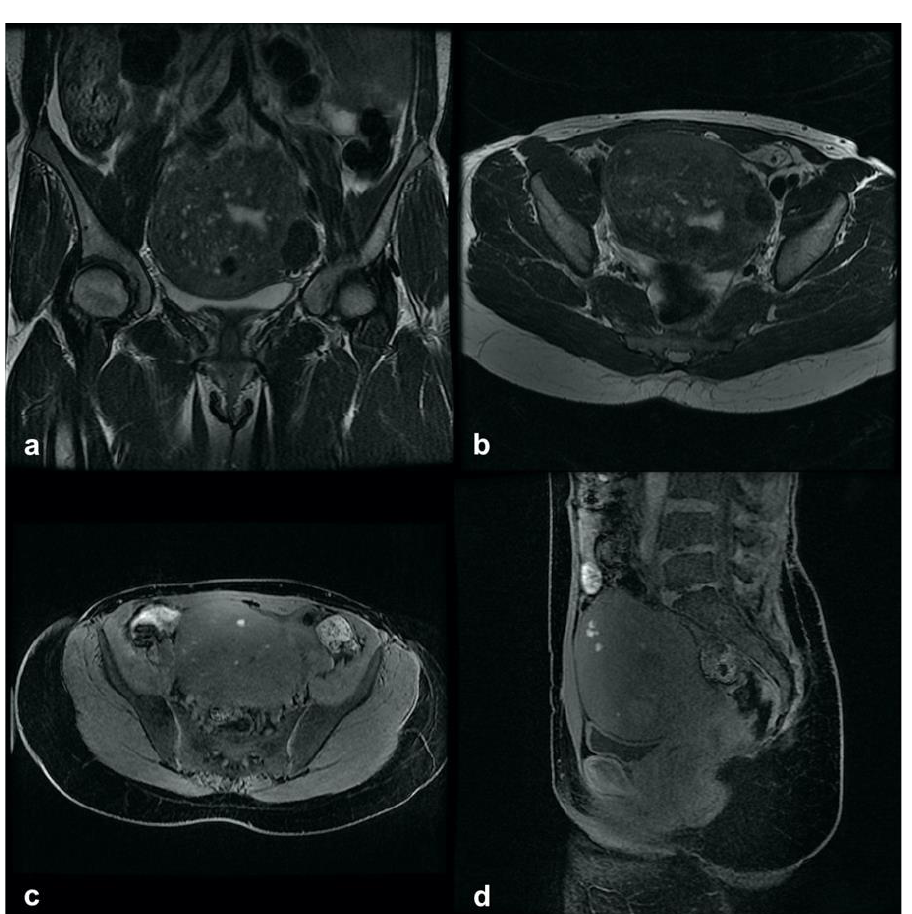
Figure 3. Diffuse asymmetrical internal adenomyosis: ( a , b ) Coronal and axial T2-weighed images showing an enlarged uterus with irregular thickening of the JZ, which appears as an ill-defined area, hypointense on T2W localized in the anterior myometrium. The lesion contains small high-intensity myometrial foci which represent ectopic endometrial tissue and small cysts. Two leiomyomas are also visible on the anterior and left lateral uterine wall as hypointense masses with well-defined borders. ( c , d ) Sagittal and axial T1-weighted fs image showing high-signal-intensity spots representing hemorrhagic content of the ectopic endometrial tissue.